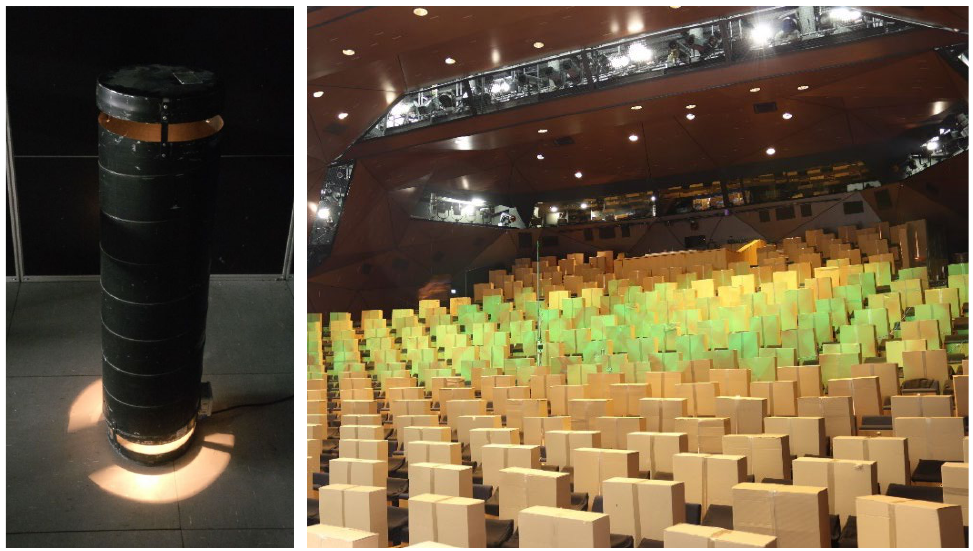
Figure 3. Professional thermal person dummy ( left ), low cost variants in Stuttgart Drama The- atre ( right ).